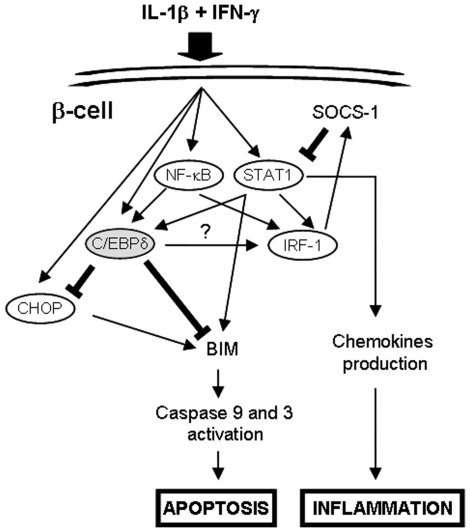
Suggested model for the role of C/EBPδ signalling in cytokine-treated β-cells.Transcription factors are highlighted in circle, thin arrows represents positive (inducing) effects, while bold T-shaped lines represent inhibitory effects. Upon IL-1β+IFN-γ exposure, C/EBPδ is up-regulated downstream of the transcription factors NF-κB and STAT1. Once synthesized, it inhibits CHOP and BIM expression, hampering cytokine-induced caspase 9 and 3 cleavage and apoptosis. C/EBPδ also exerts a positive role on cytokine-induced IRF-1 expression, which, via the induction of the regulator SOCS-1, down-regulates STAT1 activation and STAT1-driven chemokine production.